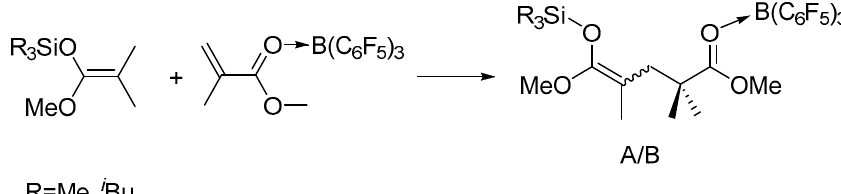
6 of 19 Figure 3. Plots of M n and Ð values of PMMBL samples vs MMBL conversion by i Bu SKA/B(C 6 F 5 ) 3 system with MMBL/ i Bu SKA/B(C 6 F 5 ) 3 = 400/1/1 ratio at RT. 2.3. Characterization of Key Intermediates To gain more insights into the polymerization, we studied the in situ NMR reactions of Me SKA with B(C 6 F 5 ) 3 in 1:1 ratio and observed the formation of FLP, which is evidenced by the fact that there is no obvious interaction observed in the reaction of Me SKA with B(C 6 F 5 ) 3 (Figures S11 and S12). Similar FLP was generated in the reaction of i Bu SKA with B(C 6 F 5 ) 3 in 1:1 ratio (Figures S13 and S14), too. We also prepared B(C 6 F 5 ) 3 ·MMA (Figures S7 and S8) and B(C 6 F 5 ) 3 ·MMBL (Figures S9 and S10) adduct for the study of their reaction with SKA, respectively. The reaction of Me SKA with B(C 6 F 5 ) 3 ·MMA at room temperature in C 6 D 6 generated major products of dimeric SKA analogue